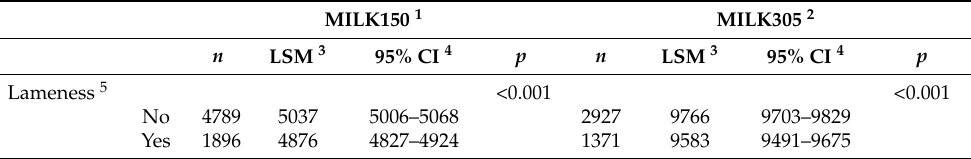
Table 1. Linear regression models assessed the association between lameness with milk yield in grazing dairy cows ( n = 6685 lactations for MILK150 and 4298 lactations for MILK305) from a commercial dairy herd evaluated for 7.5 years (January 2010–June 2017).